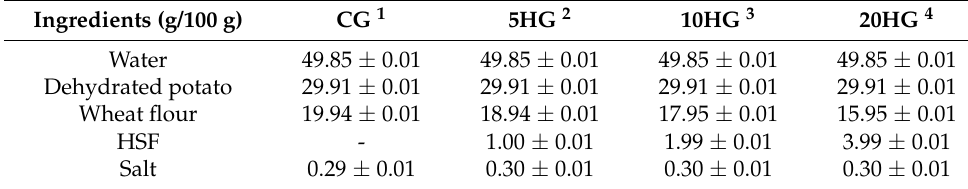
Table 1. Control and hemp seed flour-enriched gnocchi formulations. Ingredients (g/100